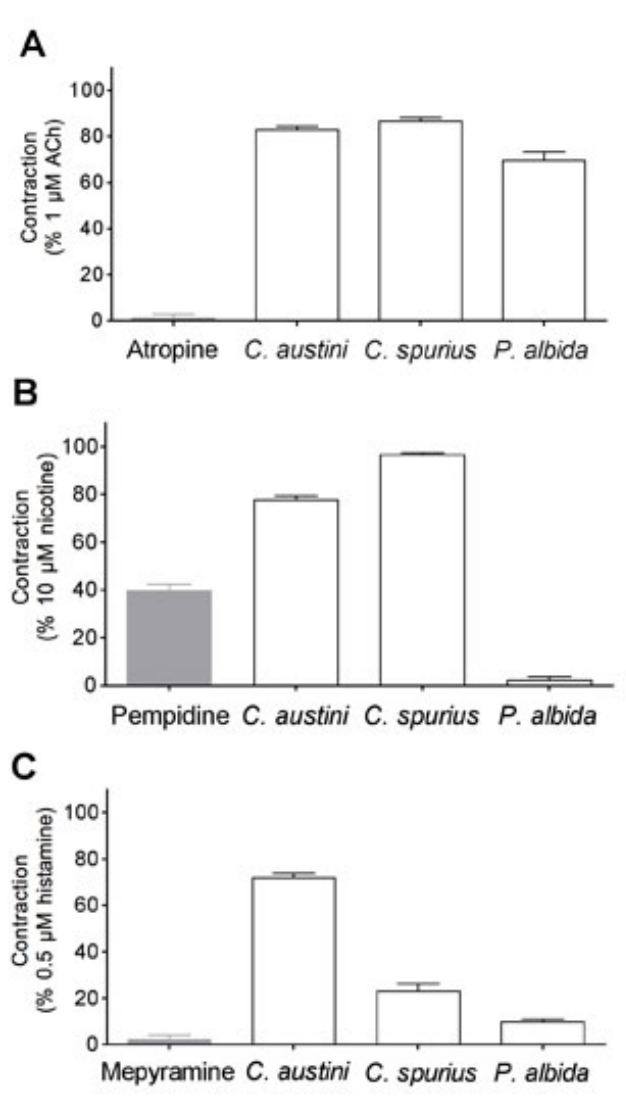
Figure 5. Effect of the extracts prepared from C. austini , C. spurius and P. albida venom ducts (10 µg protein/mL) on contractions elicited by ( A ) 1 µM ACh, ( B ) 10 µM nicotine and ( C ) 0.5 µM histamine. Values are expressed as percentages of the mean responses when the agonist alone was added to the bath, calculated as the mean from six measurements ±